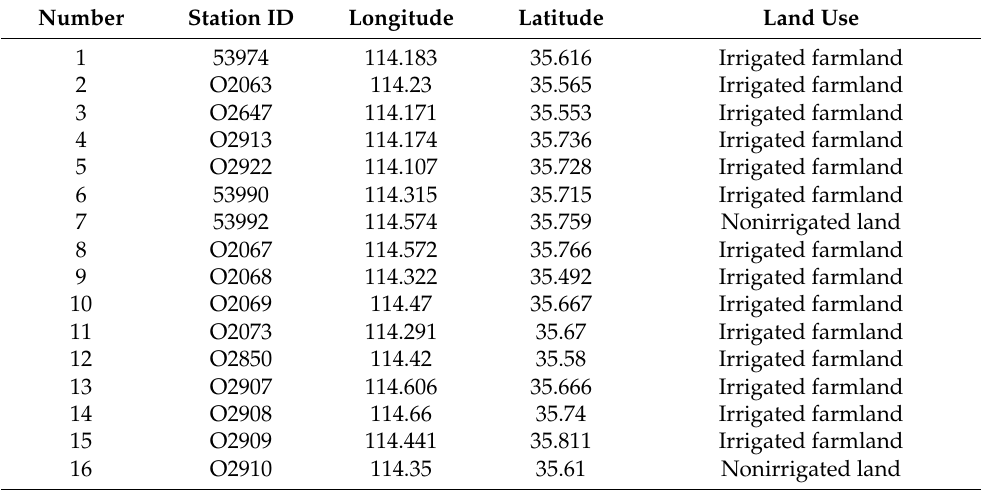
Table 2. Locations and land use for the 16 in situ soil moisture